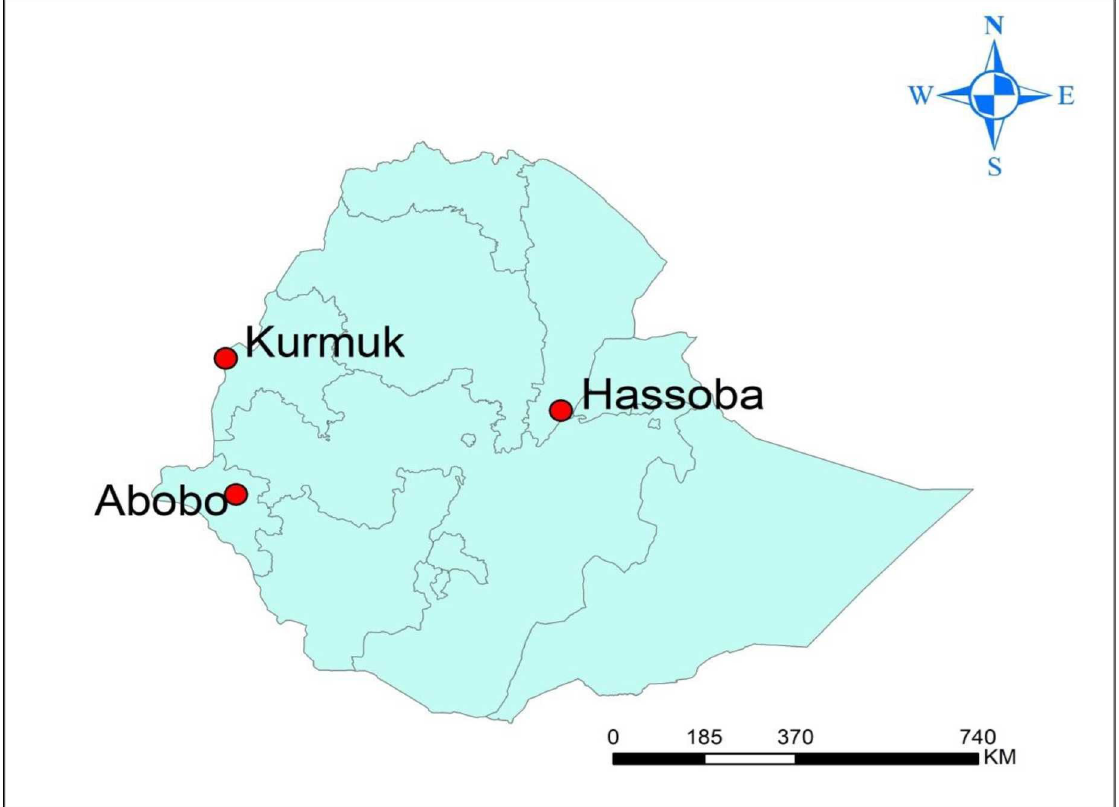
Fig 1. Map of study areas (source: Authors of this manuscript, created using ArcGIS version 10.5).